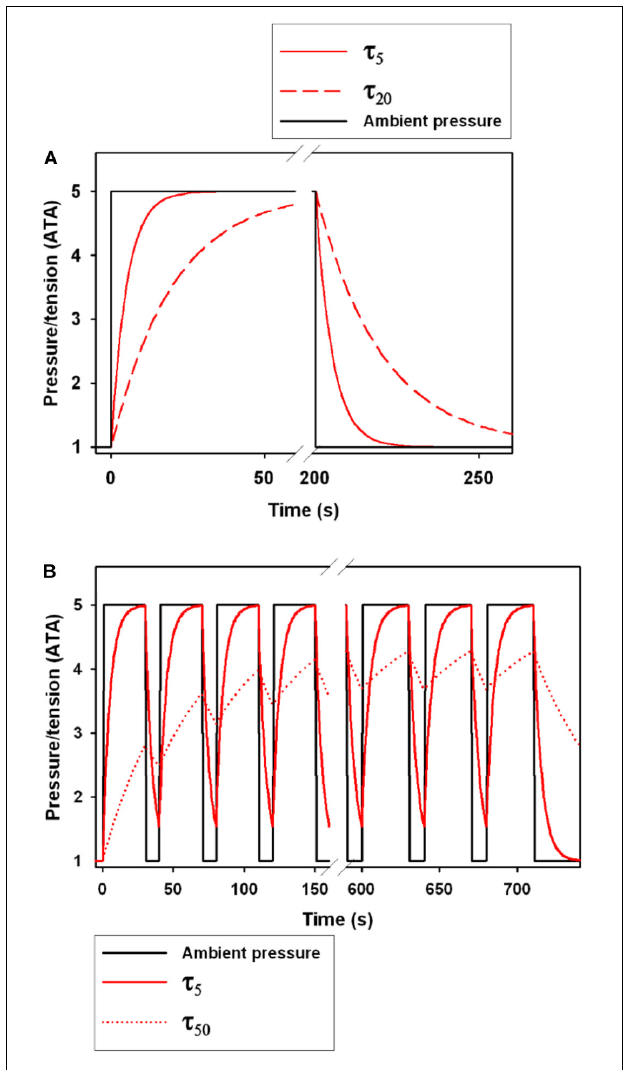
FIGURE 1 | The effect of the tissue half-time ( τ tiss1 / 2 , τ in figure legend) on gas tension following a step change in ambient pressure. (A) shows a single dive to 5 ATA (40 m) with a step change in pressure. Black solid line shows the ambient pressure, and the red lines show changes in tension for a τ tiss1 / 2 of 5 s ( τ 5 , solid red line) and 20 s ( τ 20 , broken red line). The area under the curve following decompression is the level of supersaturation and the greater the area the greater the likelihood of bubble formation (Berghage et al., 1974; Weathersby et al., 1984; Fahlman, 2017). (B) shows 18 repeated compression and decompression events to 5 ATA with time at pressure at 30 s and time at 1 ATA at 10 s. The solid and broken red lines are the